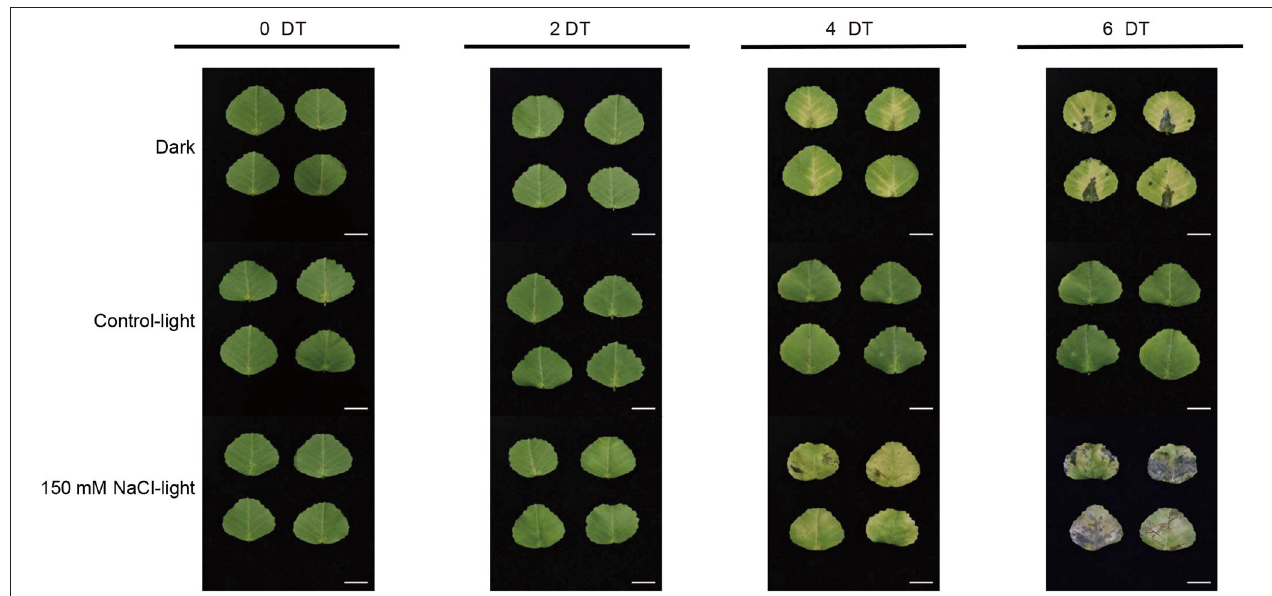
FIGURE 1 | Salt stress-induced leaf senescence in Medicago truncatula . The leaf color and senescence progression of detached M . truncatula leaves under dark (Dark), normal light (Control-light), and 150mM NaCl (150mM NaCl-light) conditions for 0, 2, 4, and 6 days. DT, day(s) of treatment. Scale bar,